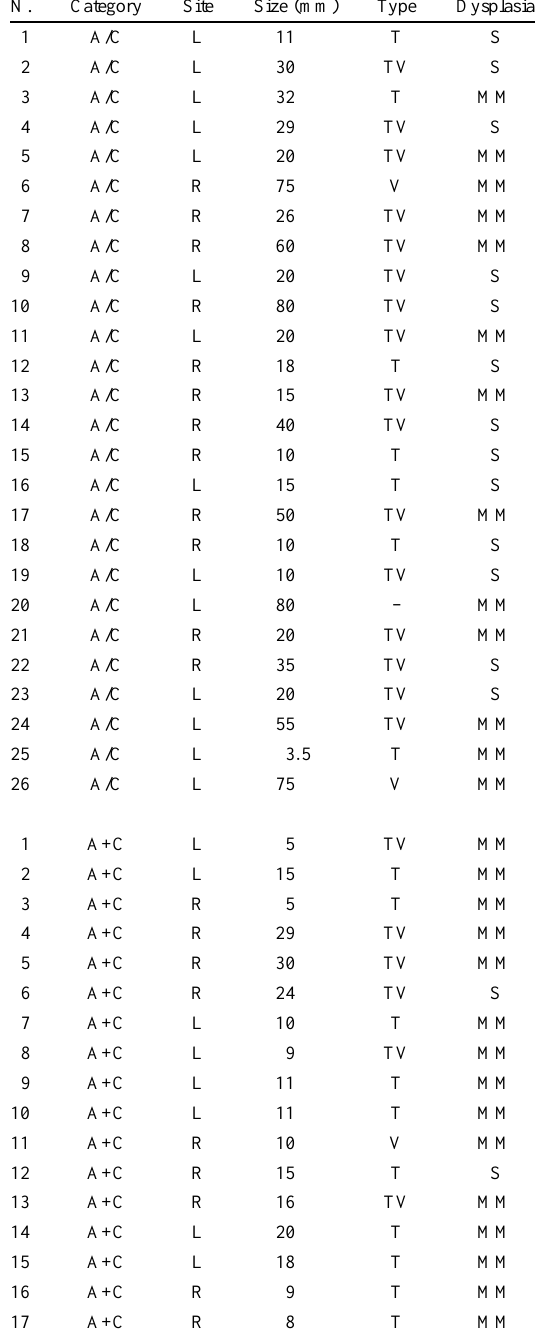
Site, size, type, and dysplasia of 26 adenomas containing early can- cer (A/C) and 17 adenomas having cancer in the near vicinity (A+C)